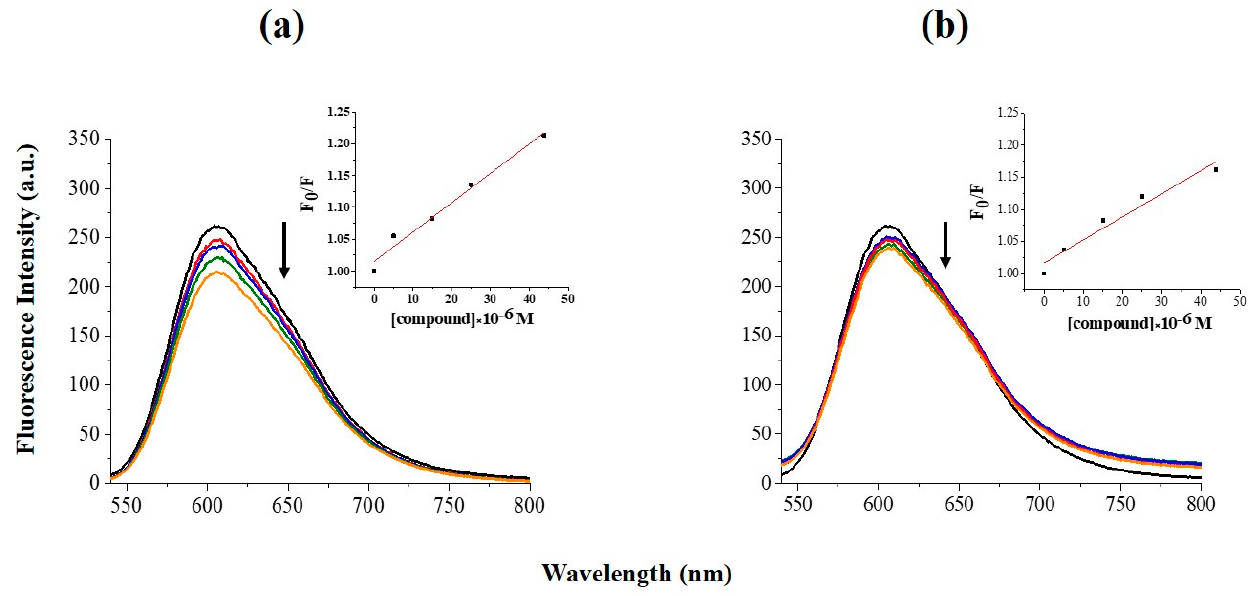
Figure 6. Fluorescence titration spectra of EtBr–CT-DNA complex with ( a ) complex Cu-1 and ( b ) ligand L1 ; [DNA] = 2.50 × 10 − 5 M, [EtBr] = 6.25 × 10 − 6 M. Arrow shows change in intensity with increasing concentration of compounds (0.00–2.20 × 10 –5 M). Inset: Plot of F 0 /F vs. [compound] × 10 − 6